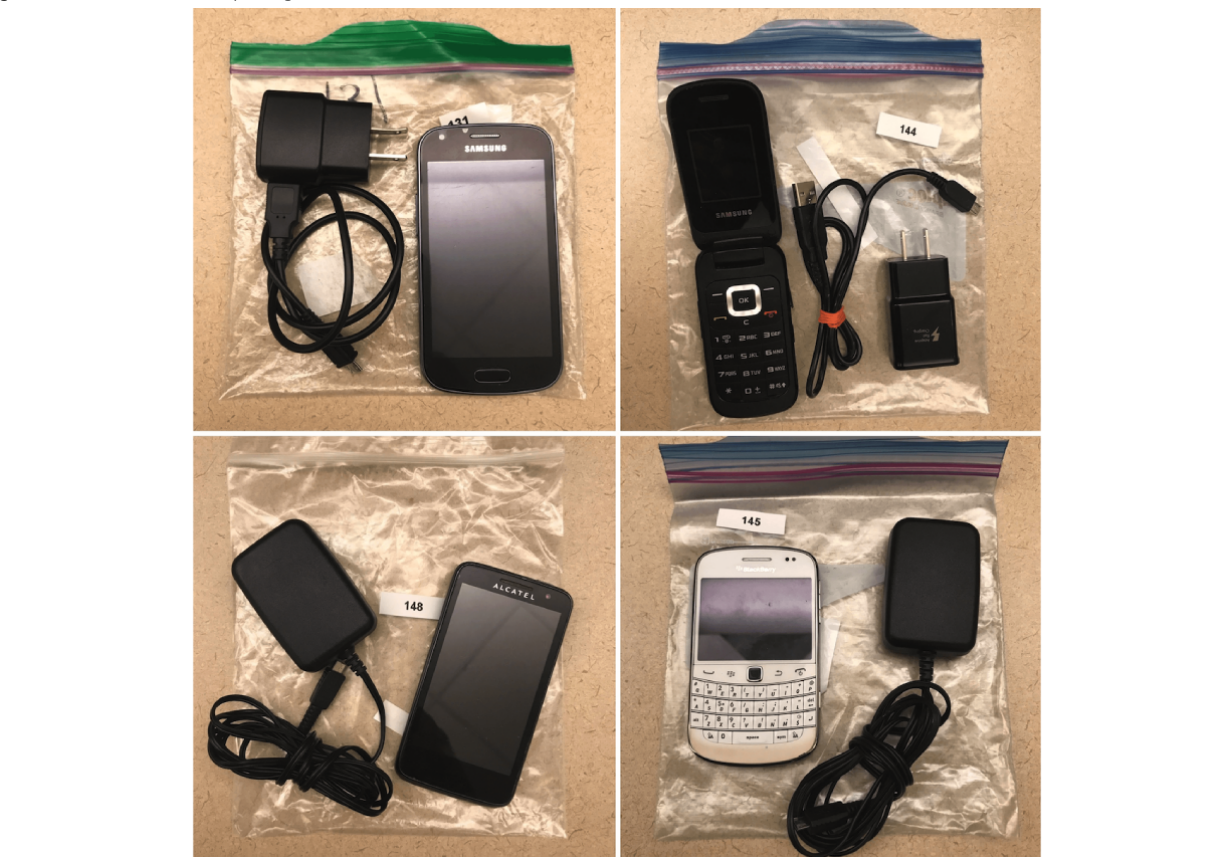
Figure 1. Phone distribution